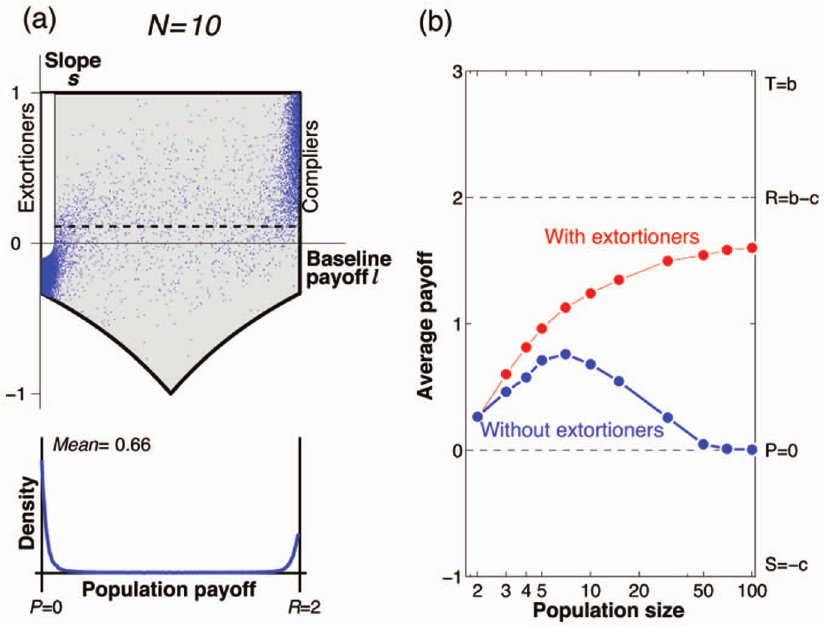
Figure 4. Extortioners facilitate cooperation. In order to study the impact of extortioners on the evolutionary dynamics, we have excluded all mutant strategies that are d -close to the set of extortioners. (a) For the simulations we have used d ~ 0 : 1 , represented by the white area in the upper left corner of the panel. (b) As a result, we find for all population sizes N w 2 that the removal of extortioners decreases the average payoff. This decrease is particularly dramatic in large populations, N § 50 . Parameters are the same as in Fig. 3.